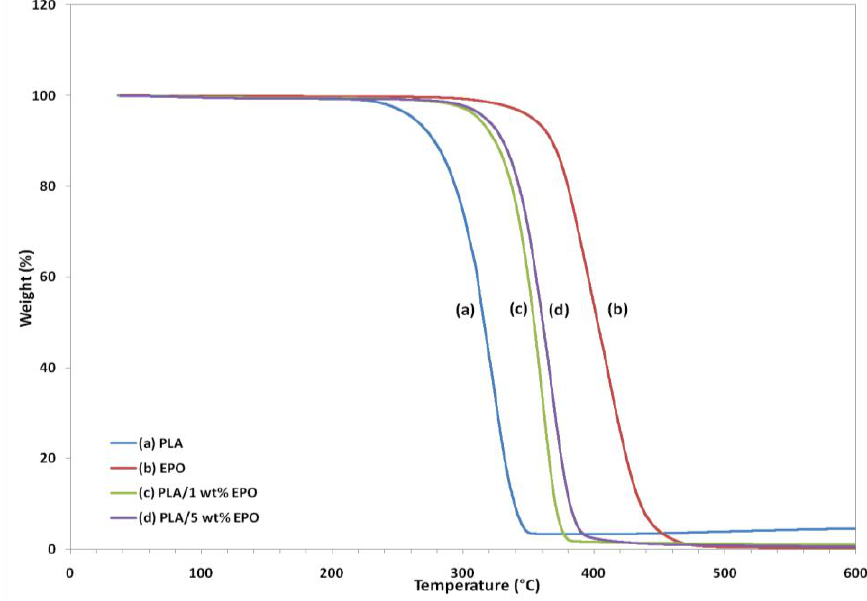
Figure 11. TG thermograms of neat PLA and PLA/EPO blends.